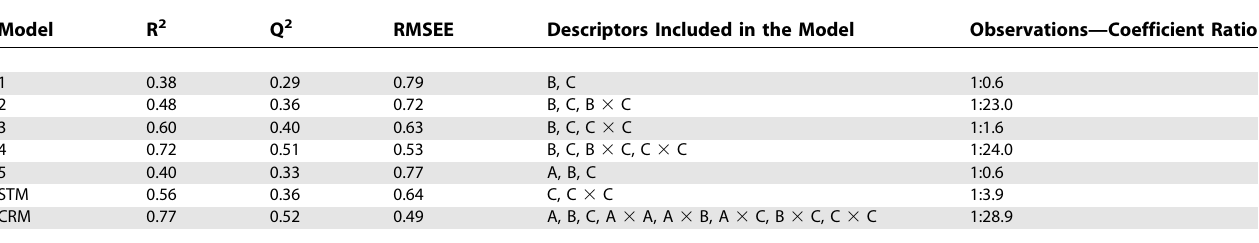
Table 1. Creation of a Substratethe CRM for Retroviral Proteases